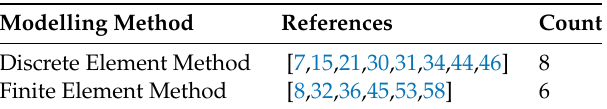
Table 15. Frequency of soft jamming robot modelling per